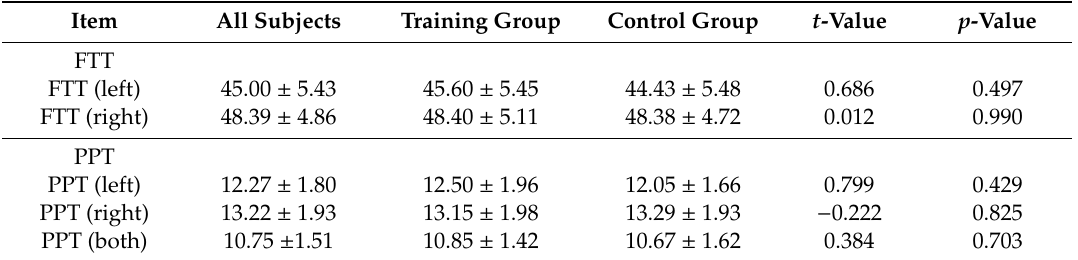
Table 6. Psychomotor Speed ( N = 41, and X ±